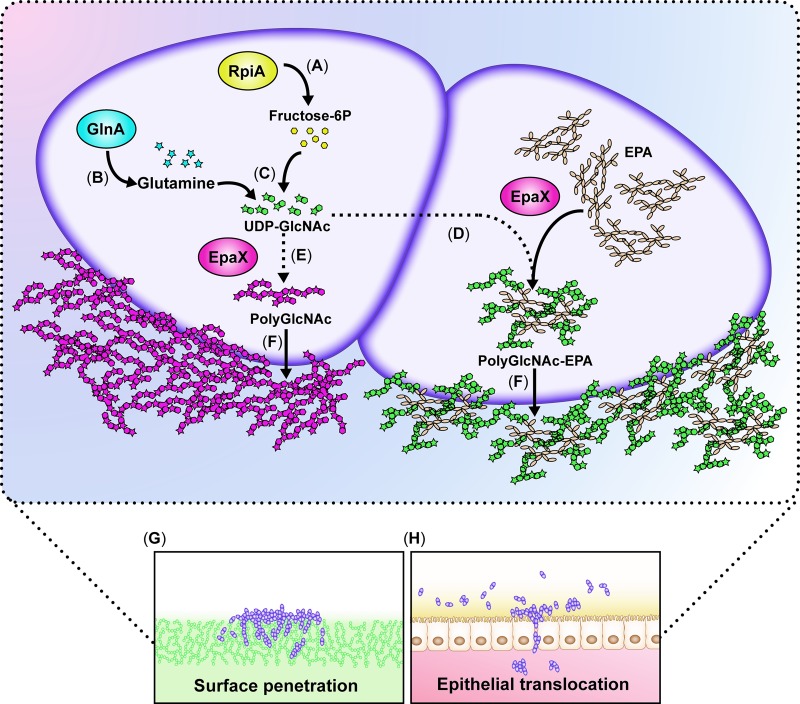
Proposed model for E. faecalis surface penetration using polyGlcNAc-containing polymers.(A) RpiA is required to generate ribulose-5-phosphate, a substrate that could be converted into fructose 6-phosphate (Fructose-6P) in the non-oxidative phase of the pentose phosphate pathway. (B) GlnA generates glutamine from glutamate and ammonia. (C) Cellular fructose-6P and glutamine converge in the hexosamine biosynthetic pathway to ultimately generate UDP-GlcNAc, which is used by EpaX to synthesize an enterococcal polyGlcNAc-containing polymer, which could be a decoration of the rhamnopolysaccharide EPA (D) or a yet unknown polymer (E). These polyGlcNAc-containing polysaccharides are extracellularly localized (F) and promote the movement and penetration of E. faecalis into semisolid surfaces (G) or through human epithelial cell monolayers (H). In the absence of a functional RpiA or GlnA, the levels of UDP-GlcNAc are not sufficient to promote polysaccharide synthesis, thus blocking efficient surface penetration and/or translocation.